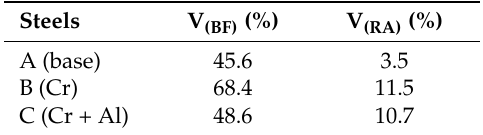
Table 3. The volume fractions of bainite ferrite (BF) and retained austenite (RA) in three steels.